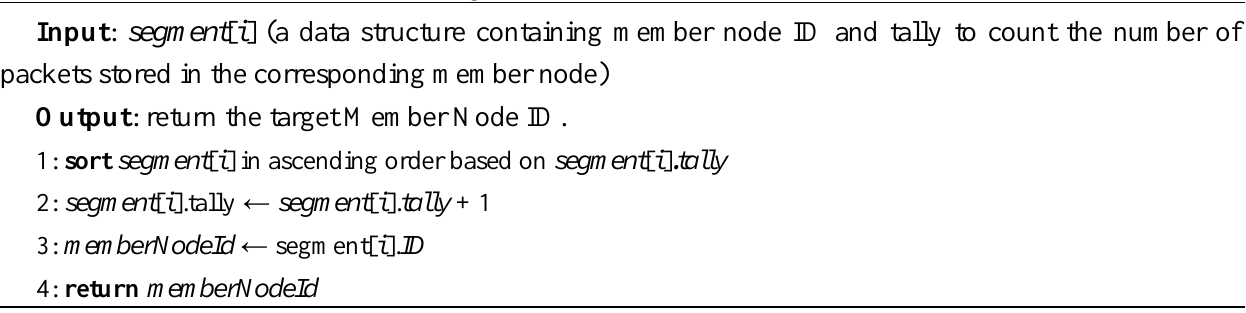
Algorithm 5. Search_Target_Node ( segment [ i ]), implemented at each SH node.